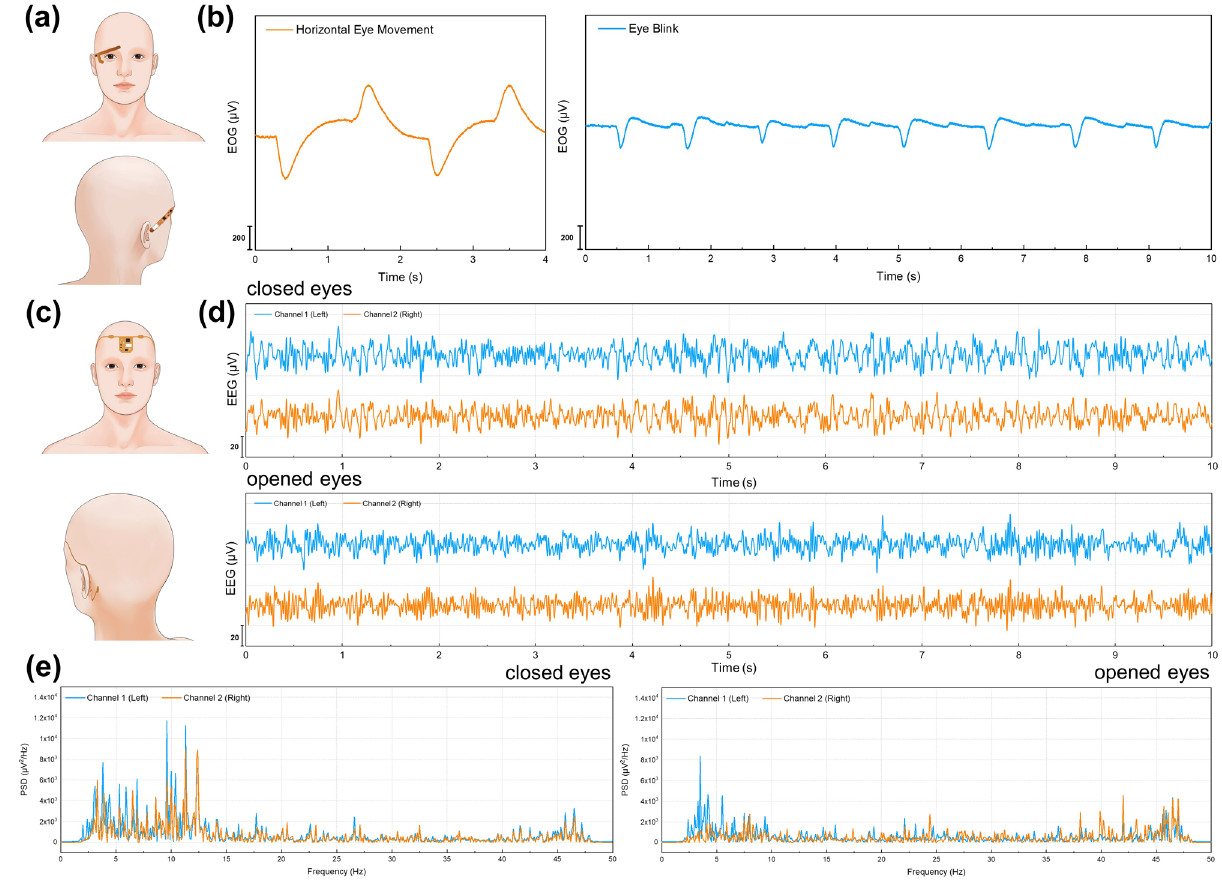
Fig. 6 a Wearing position for EOG wireless recording. b EOG waveforms during a horizontal eye movement and eye blink. c Wearing position for EEG wireless recording. d Two-channel frontal EEG waveforms when eyes were closed and opened. e Frequency analysis of frontal EEG (PSD: power spectral